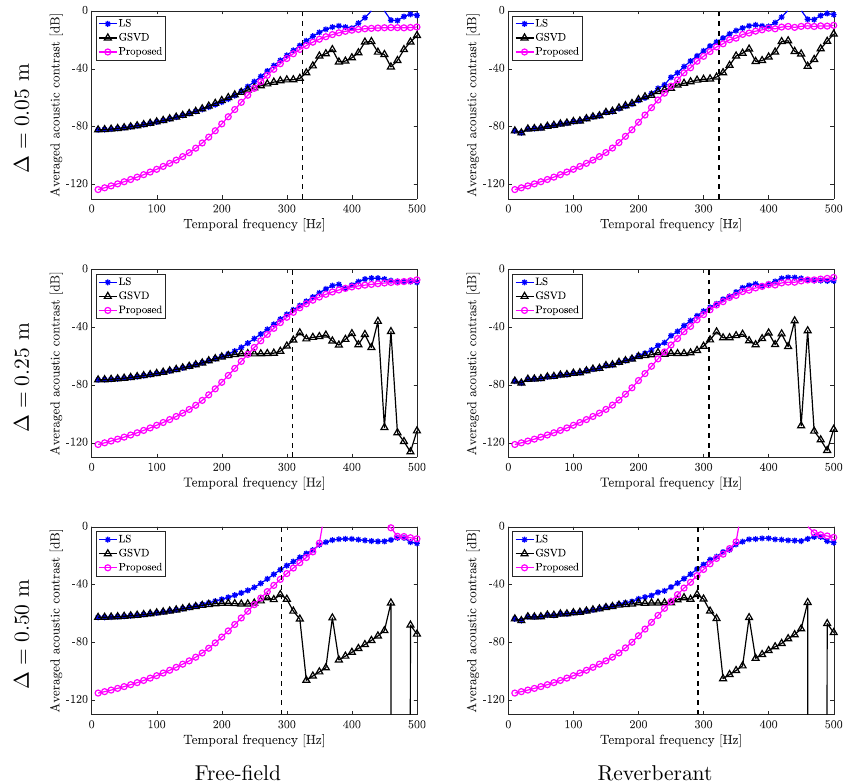
Figure 9. Results of spatially-averaged acoustic contrast for exterior sound field with 2.5 m ≤ r ≤ 4.5